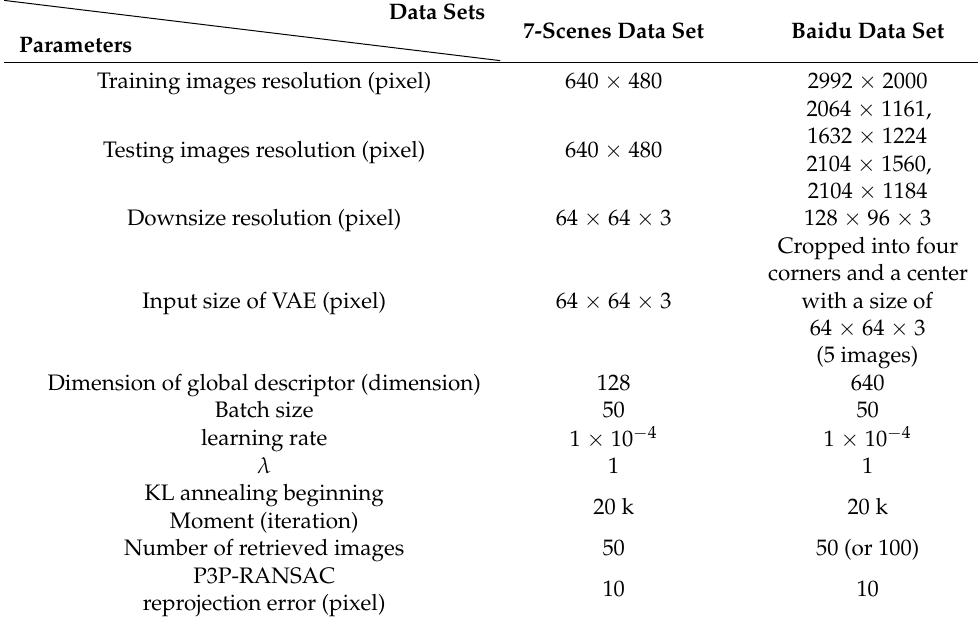
Table 1. Parameter settings in different stages of different data sets.